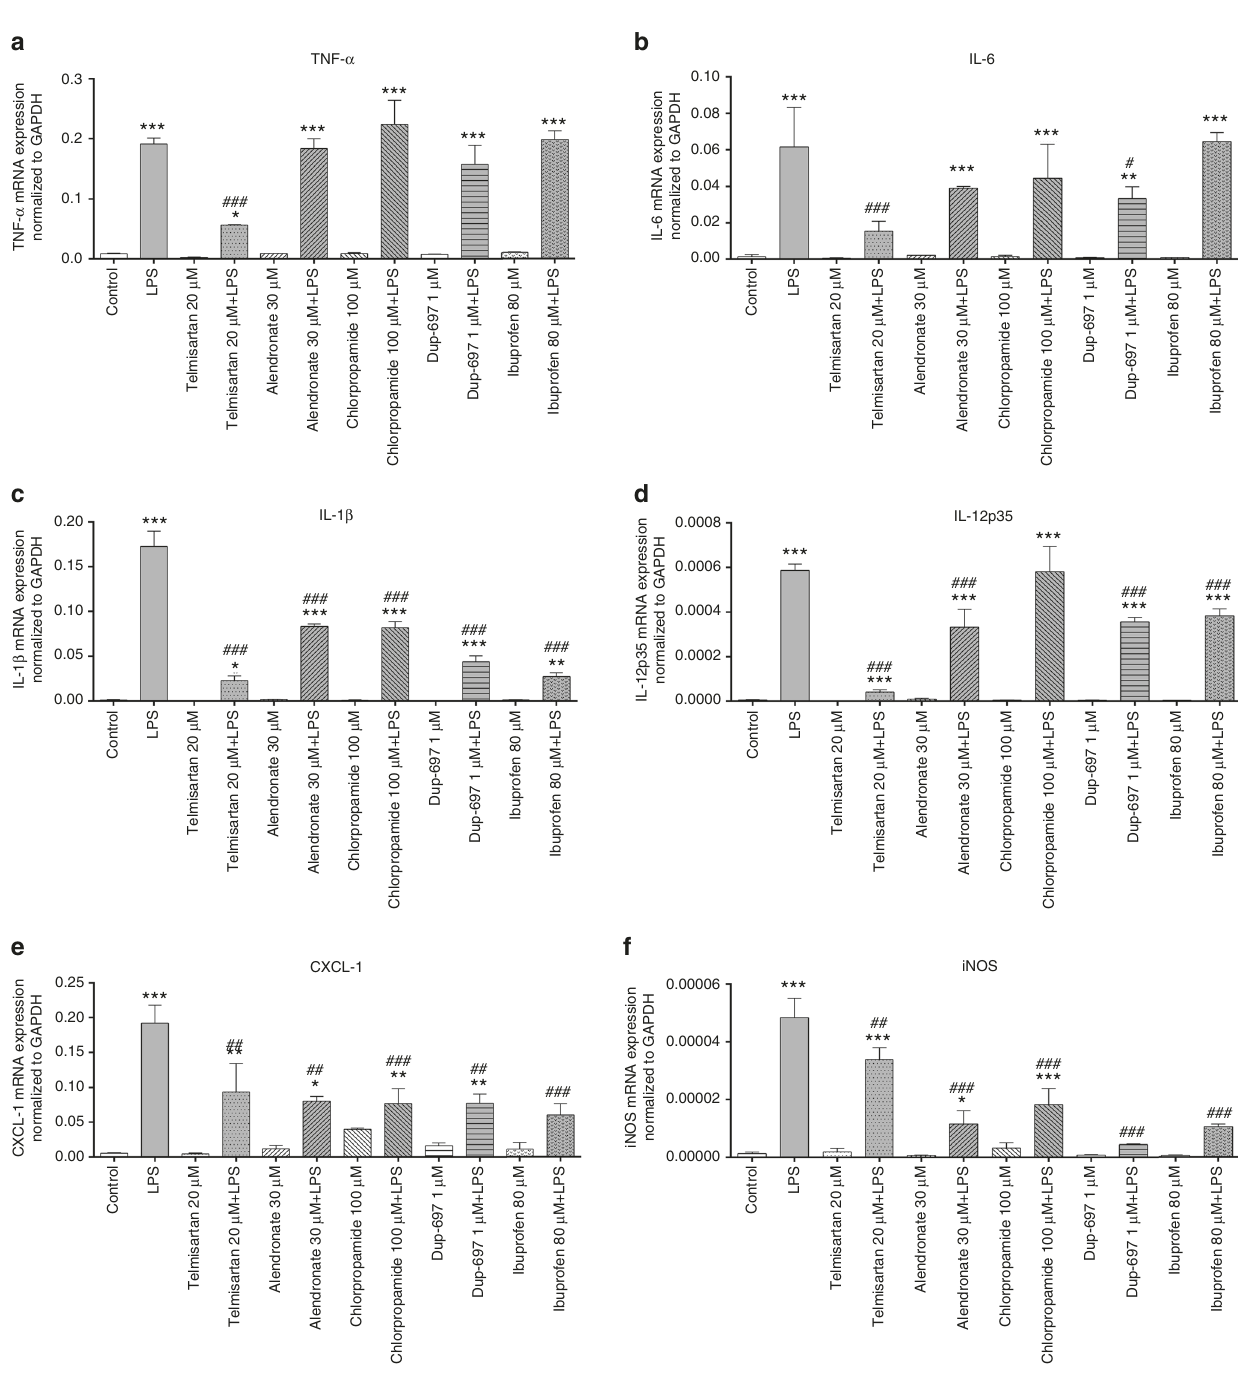
Fig. 7 The real-time PCR (RT-PCR) analyses of the proin fl ammatory factors on the LPS-stimulated macrophages. a – f The RT-PCR analysis of mRNA expressions of TNF α , IL-6, IL-1 β , IL-12p35, CXCL-1 and iNOS normalized relative to that of GAPDH, respectively. Control, macrophages without LPS treatment. *: P < 0.05; **: P < 0.01; ***: P < 0.001, compared to the samples without LPS treatment. ##: P < 0.01; ###: P < 0.001, compared to the